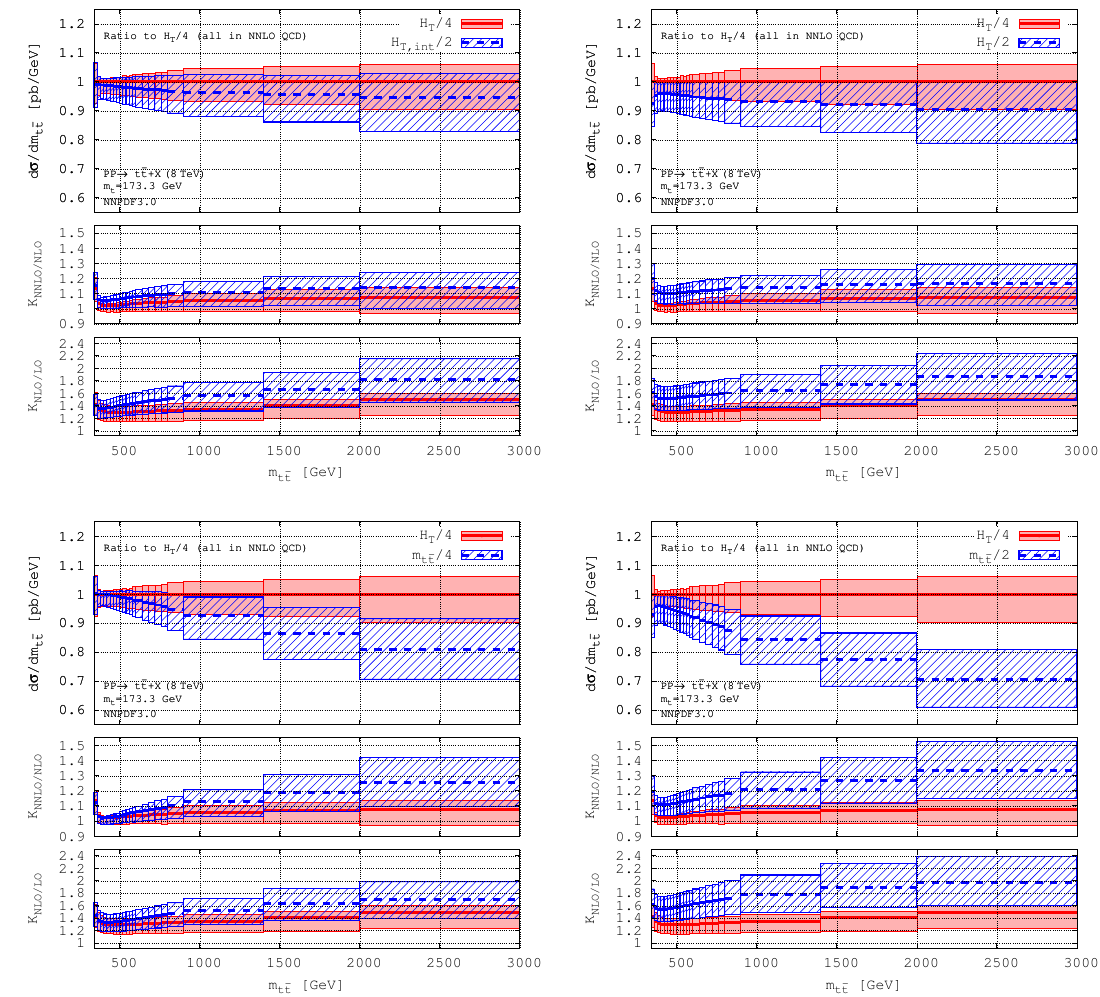
Figure 6 . Comparison of the m di(cid:11)erential cross-section at NNLO evaluated with (cid:12)ve di(cid:11)erent t (cid:22) t dynamic scales. All plots show ratios with respect to the default scale H T = 4 (3.9): H T; int = 2 (top left), H T = 2 (top right), m = 4 (bottom left) and m = 2 (bottom right). Error bands are from scale t (cid:22) t t (cid:22) t variation